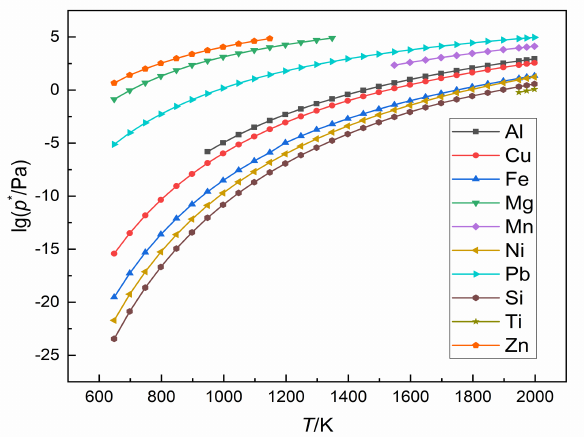
Figure 3. The relationship between the vapor pressure logarithm and the temperature of different